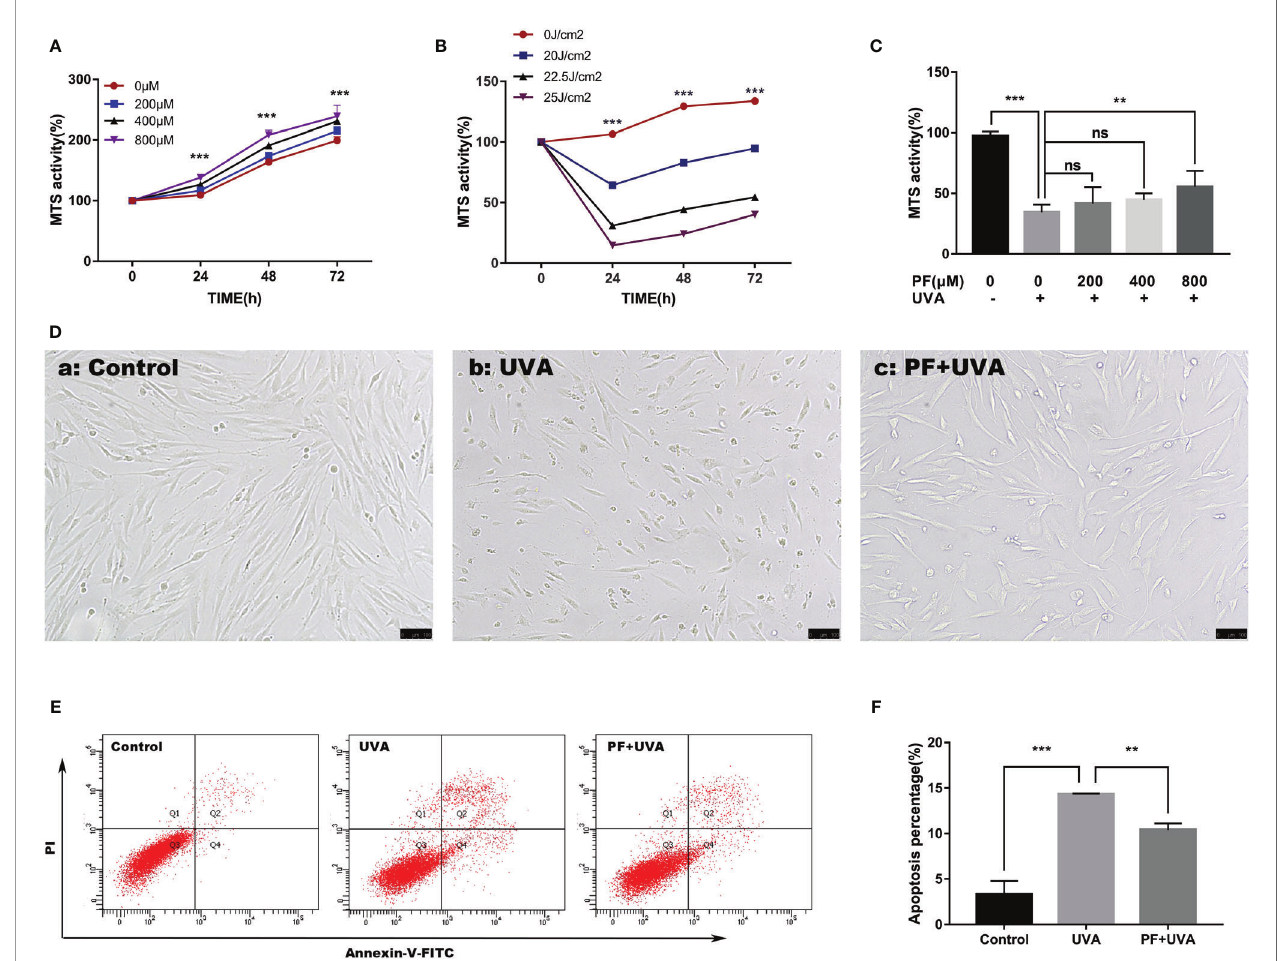
FIGURE 1 | PF suppressed UVA-induced injuries in HDFs. (A) MTS assay on the cytotoxicity of PF (0, 200, 400, and 800 m M) in fi broblasts at 24, 48, and 72 h. (B) MTS assay on the cytotoxicity of UVA (0, 20, 22.5, and 25 J/cm 2 ) in fi broblasts at 24, 48, and 72 h. (C) MTS assay detected the cytoprotective function of PF (0, 200, 400, and 800 m M) against UVA (22.5 J/cm 2 ) in fi broblasts. (D) Cellular morphology of fi broblasts with different treatments visualized by inverted microscope. (E) The cells apoptosis was detected by using fl ow cytometry with annexin-V-FITC and PI staining. The Q3 quadrant contained the vital population; the Q1 quadrant contained the death cells; the Q2 quadrant contained the late apoptotic cells; the Q4 quadrant contained the early apoptotic cells. (F) The data represented the apoptosis percentage containing the Q2 and Q4 quadrants in each group. All data were expressed as the mean ± SD according to at least three independent experiments. ** p < 0.01, *** p < 0.001, ns p >